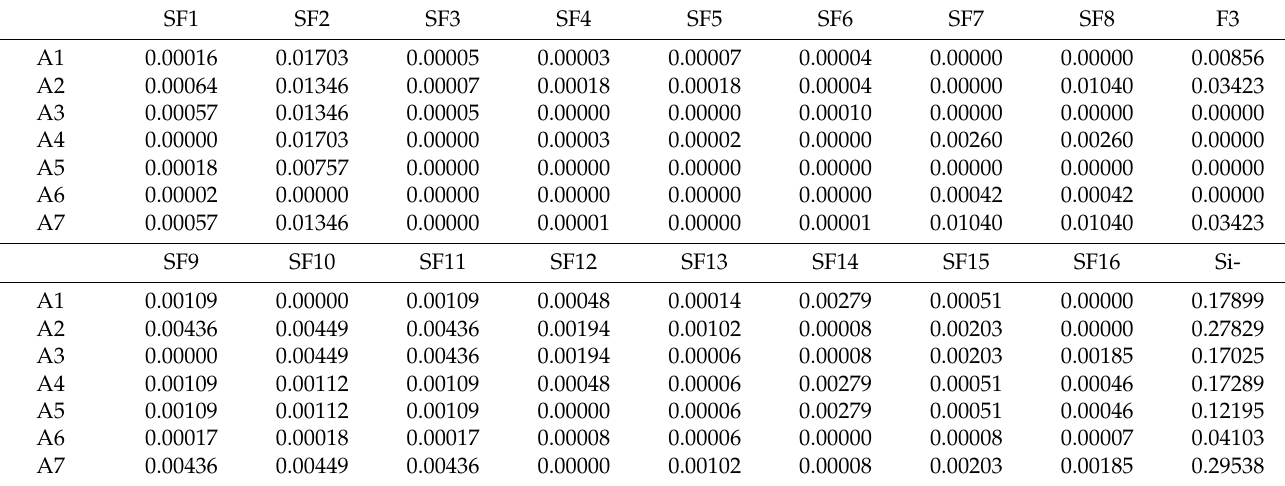
Table A9. Matrix of distances to anti-ideal